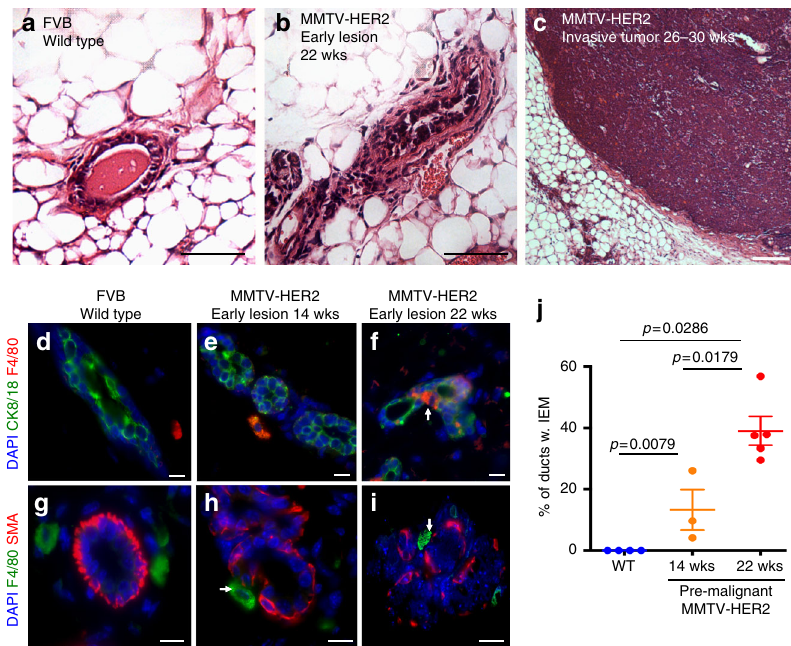
Fig. 1 Macrophages enter the ductal epithelial layer in early breast cancer lesions. H&E staining of mammary gland sections show progression from healthy mammary ducts in FVB wild-type glands (age 20wks; a ) to early lesions classi fi ed as hyperplasia and mammary intra-epithelial neoplasia (age 22wks; b ) to invasive tumors (age 26 – 30wks; c ) in the MMTV-HER2 mouse model. Bars: 100 μ m. Mammary glands from FVB wild-type (20wks; d ) or pre-malignant MMTV-HER2 mice at age 14wks ( e ) and 22wks ( f ) were stained against F4/80 (macrophages) and CK8/18 (epithelial cells) and against F4/80 and smooth muscle actin (SMA) ( g – i ). Bars: 10 μ m. The mean ± SEM of the percentage of ducts containing IEM is shown; FVB: N = 4 mice, 14wks; N = 3 mice, 22wks; N = 5 mice ( j ). P values were calculated with 95% con fi dence by Mann – Whitney